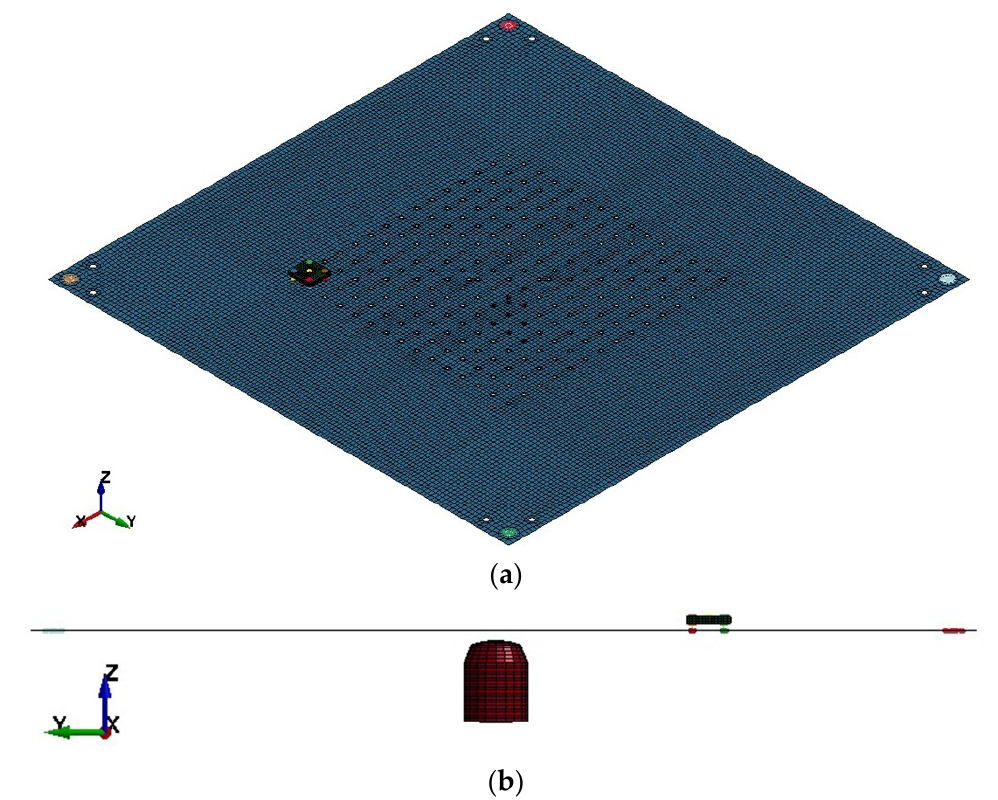
Figure 5. Finite element model of the experimental setup. ( a ) Isometric view, ( b ) side view.